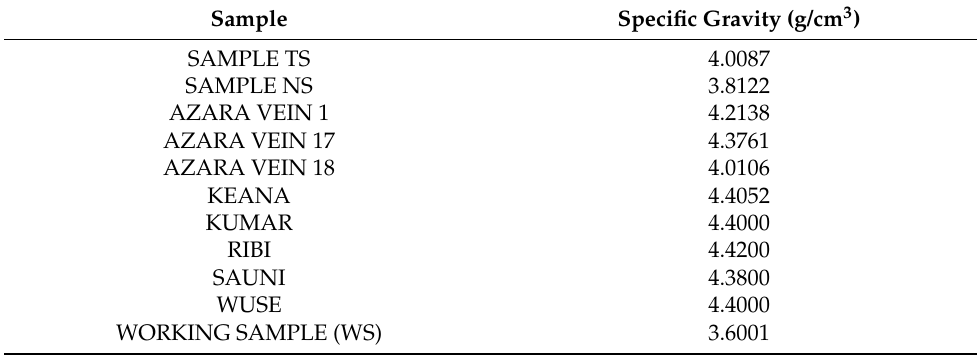
Table 3. The specific gravity of samples from different mining